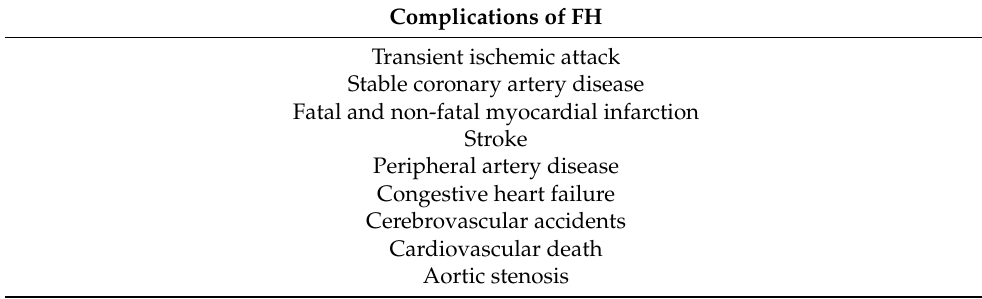
Table 3. Complications Developing in the Course of FH